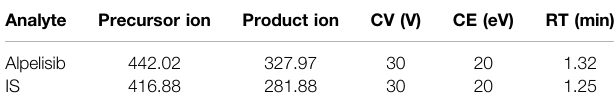
TABLE 1 | Speci fi c mass spectrometric parameters and retention times (RTs) for alpelisib and IS, including cone voltage (CV) and collision energy